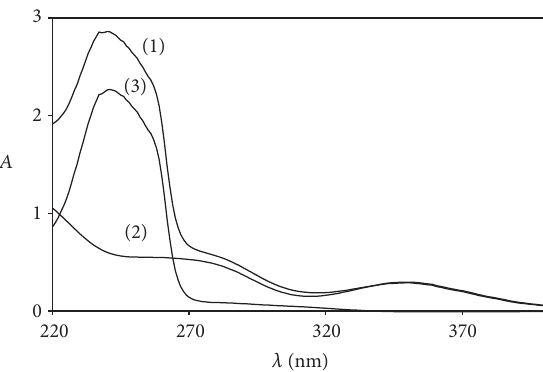
Figure 3: UV spectra of (1) 2 × 10 −4 mol ⋅ L −1 HQ in the presence of 2 × 10 −4 mol ⋅ L −1 K 2 Cr 2 O 7 (in excess), in 1mol ⋅ L −1 sulfuric acid; (2) K 2 Cr 2 O 7 at a level of concentration corresponding to those unreacted in solution (1); (3) = (1) − (2)